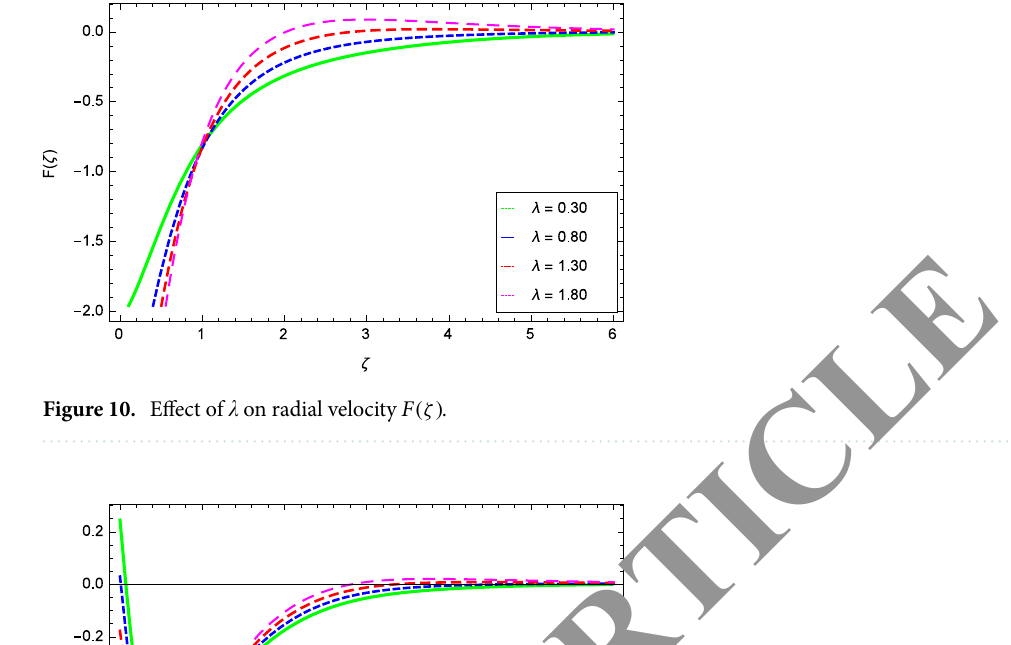
Figure 11. Effect of M on radial velocity F (ζ) .